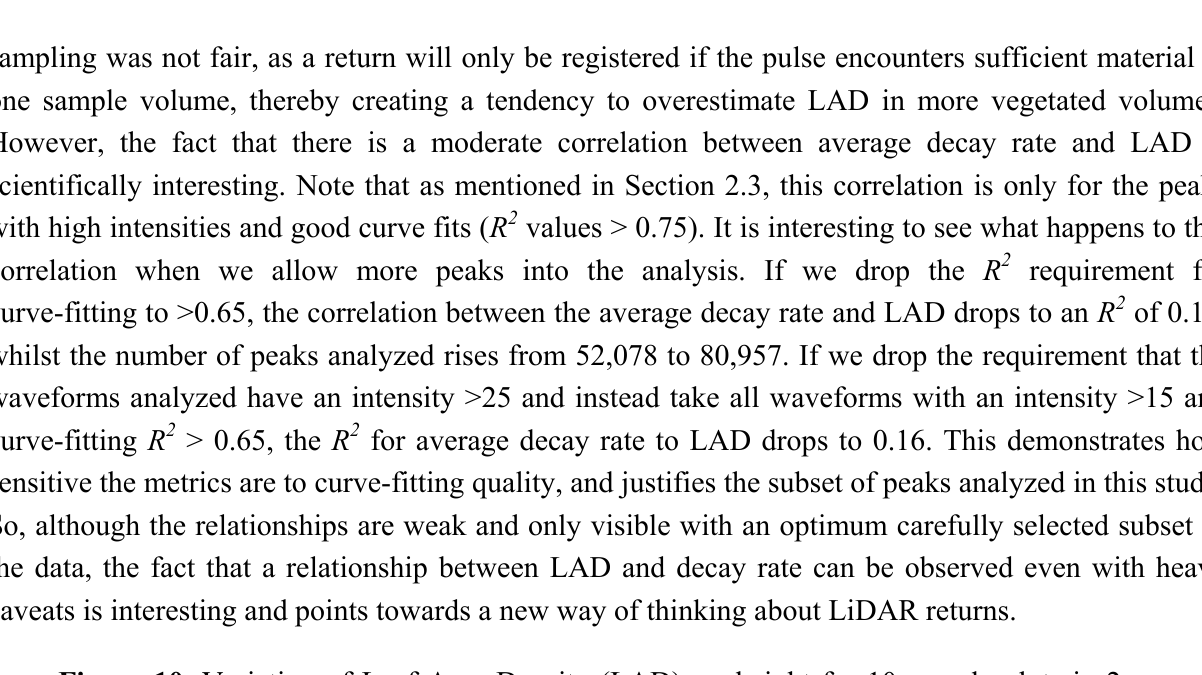
Figure 10. Variation of Leaf Area Density (LAD) vs . height for 10 sample plots in 2